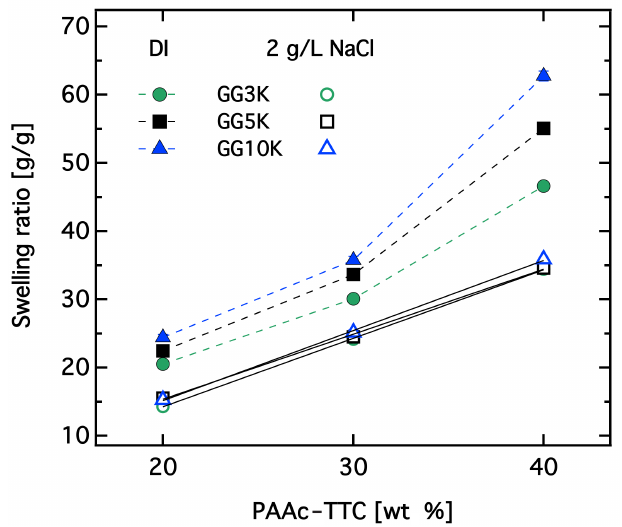
Figure 3. Equilibrium swelling ratios ( SR eq ) of the hydrogels in deionised water (DI) ( closed symbols ) and in salt solution (2 gL − 1 NaCl) ( open symbols ) as a function of the PAAc content at room temperature ( ∼ 23 ◦ C). The dashed lines are just a guide for the eye while the straight ones are linear